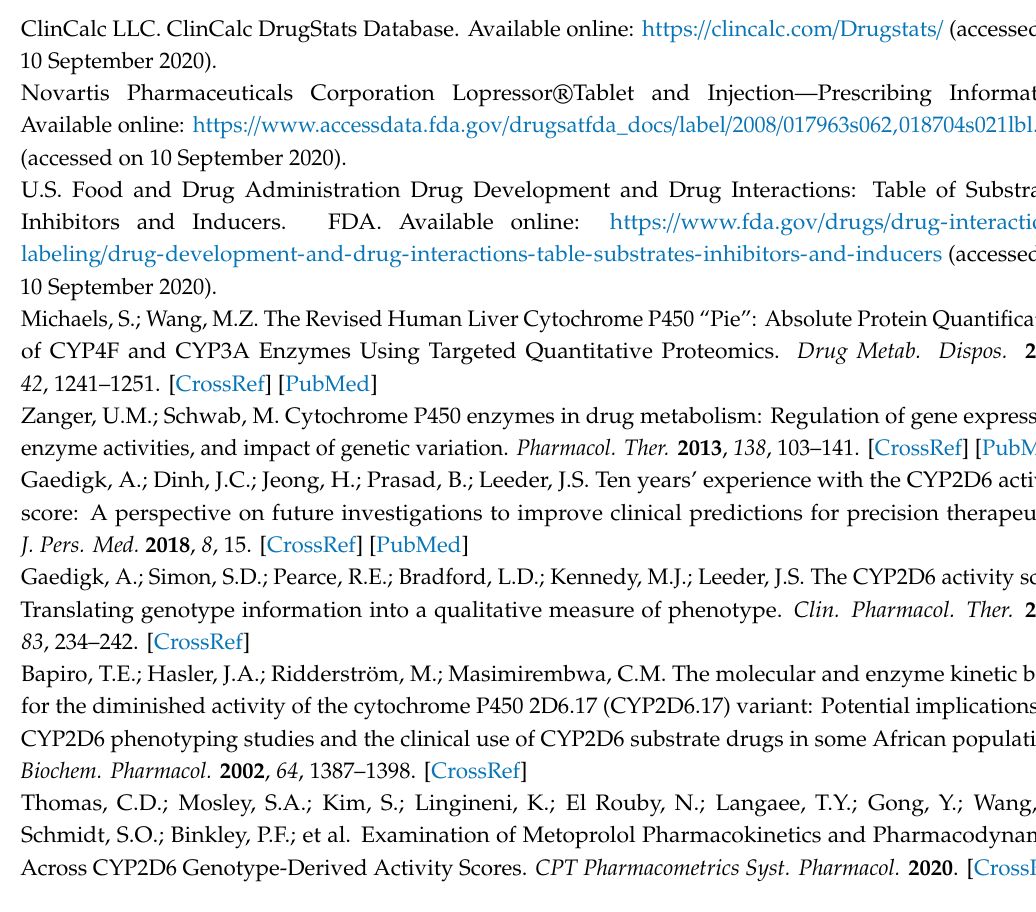
Figure S3.2.5: Metoprolol plasma concentrations of the modeled CYP2D6 drug-gene interaction, Figure S3.2.6: MetoprololplasmaconcentrationsofthemodeledCYP2D6drug-geneinteraction., FigureS3.2.7: Metoprololplasma concentrations of the modeled CYP2D6 drug-gene interaction, Figure S3.2.8: Metoprolol plasma concentrations of the modeled CYP2D6 drug-gene interaction, Figure S3.2.9: Metoprolol plasma concentrations of the modeled CYP2D6 drug-gene interaction, Figure S3.2.10: Metoprolol plasma concentrations of the modeled CYP2D6 drug-gene interaction, Figure S3.2.11: Metoprolol plasma concentrations of the modeled CYP2D6 drug-gene interaction, Figure S3.2.12: Metoprolol plasma concentrations of the modeled CYP2D6 drug-gene interaction, Figure S3.3.13: Predicted versus observed metoprolol DGI ratios. Comparison of predicted versus observed AUC last ratios (a) and C max ratios (b) for metoprolol CYP2D6 DGI-studies, Table S3.3.2: Geometric mean fold error of predicted metoprolol DGI AUC last andC max ratios, Table S4.0.1: System-dependent